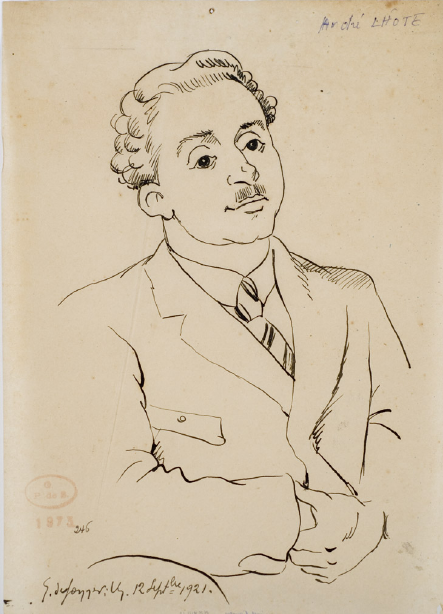
Figure 4. Georges de Sonneville, Portrait d’André Lhote , 1921, Bordeaux, musée des Beaux-Arts, photograph: F.